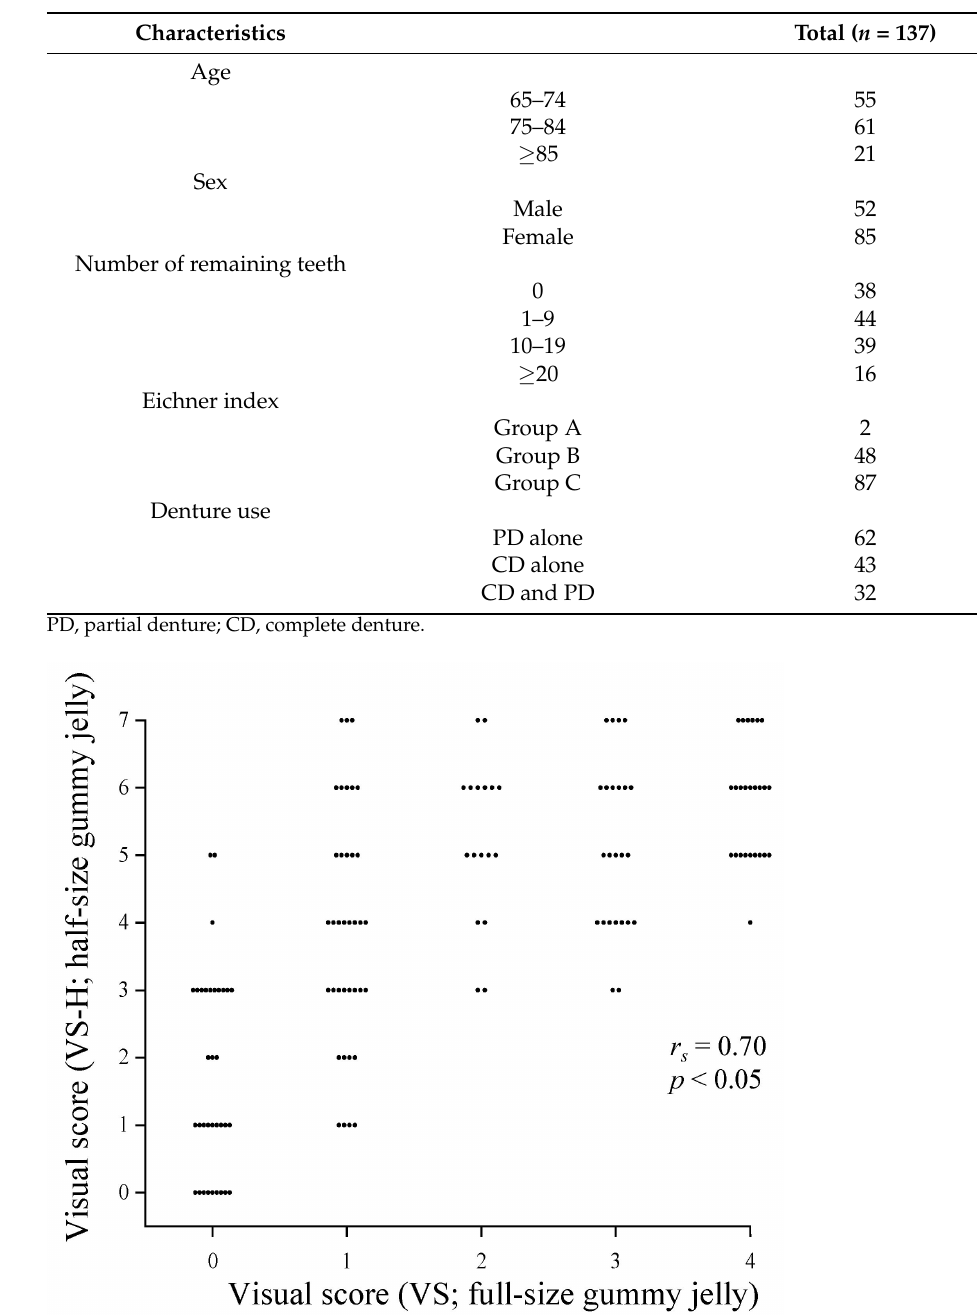
Table 1. Baseline characteristics of the participants.